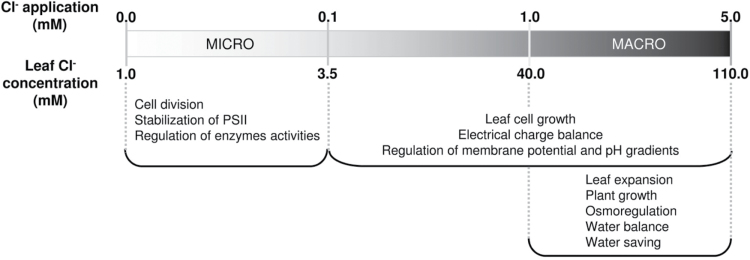
Schematic representation of Cl– functions according to availability in the micro- or macronutrient range. Different biological functions are defined according to the external Cl– application (0–5mM Cl–) or the resulting leaf bulk tissue concentration (1–110mM Cl–). Functions indicated in the 0.0–0.1mM Cl– treatment range summarize previous knowledge of Cl– roles as an essential micronutrient (see the Introduction); biological functions indicated in the 0.1–5.0mM Cl– treatment range summarize the results obtained in this work.